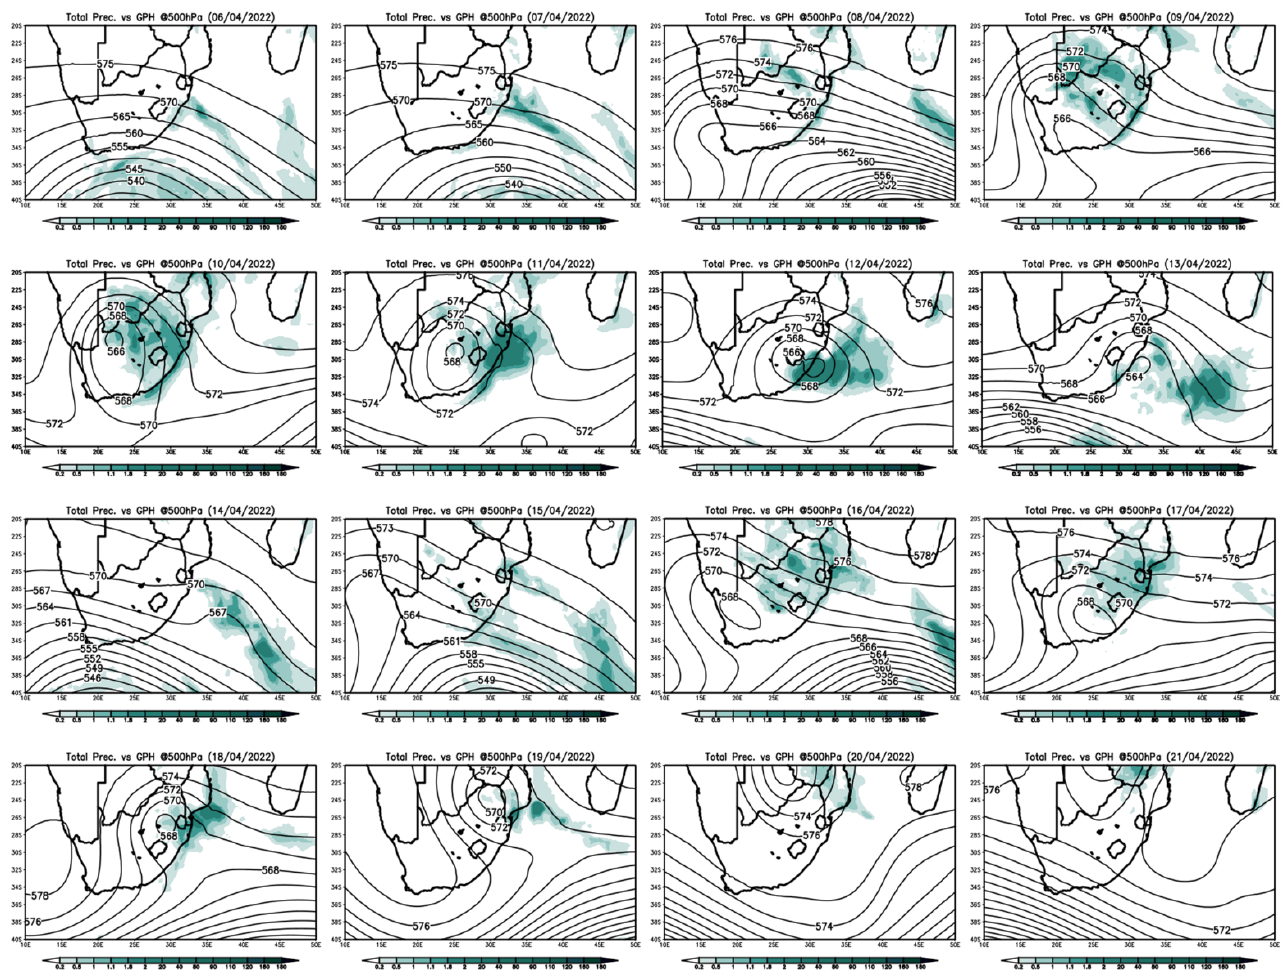
Figure 5. ERA5 geopotential heights (m) at 500 hPa and SAWS daily rainfall (mm) over South Africa during the period 6–21 April 2022.